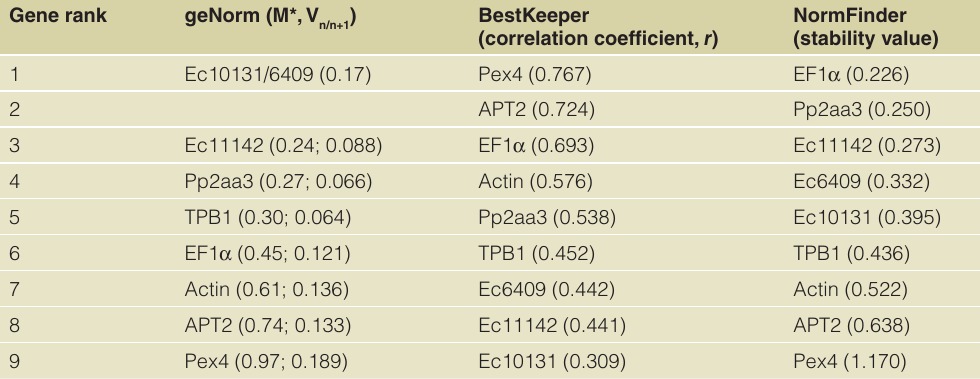
Supplementary Table 2. Ranking of Erythroxylum coca reference gene stability in a sample subset containing only matureorgans (Leaf stage III, Flowers, Roots, Stems). Analysis was performed using the geNorm, BestKeeper and NormFinder